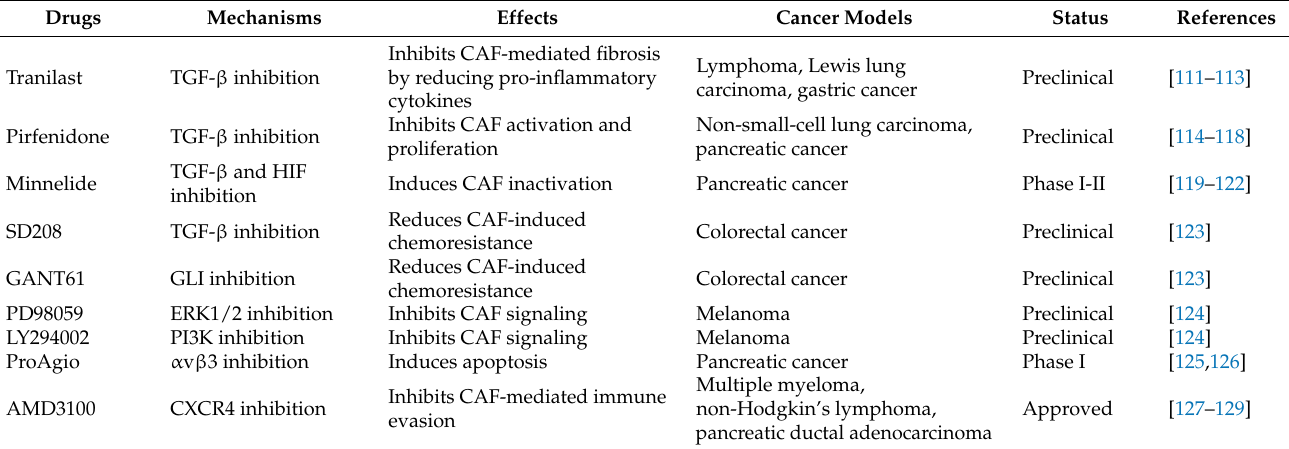
Drugs Mechanisms